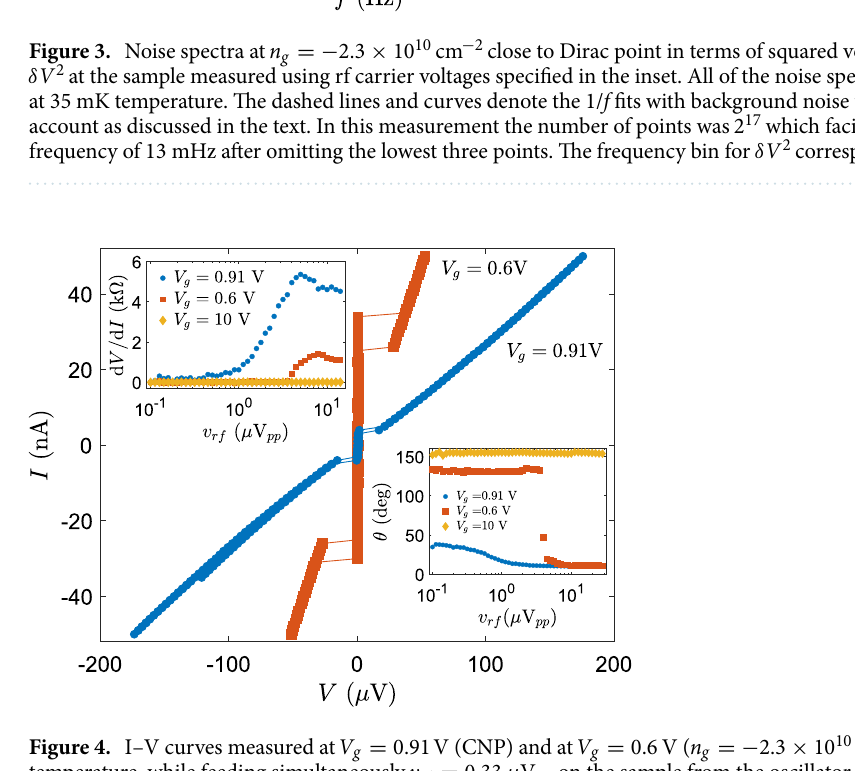
Figure 4. I–V curves measured at V g temperature, while feeding simultaneously v rf amplifier. Right inset: Reflection phase θ versus carrier amplitude v rf measured at gate voltages indicated in the figure. Left inset: Differential resistance as a function of increasing v rf measured for three different gate voltages given in the